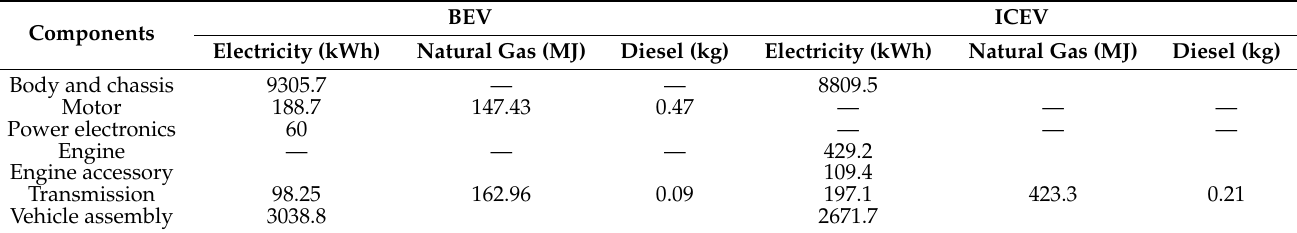
Table A4. Energy consumption inventory in the vehicle manufacturing phase (without battery).